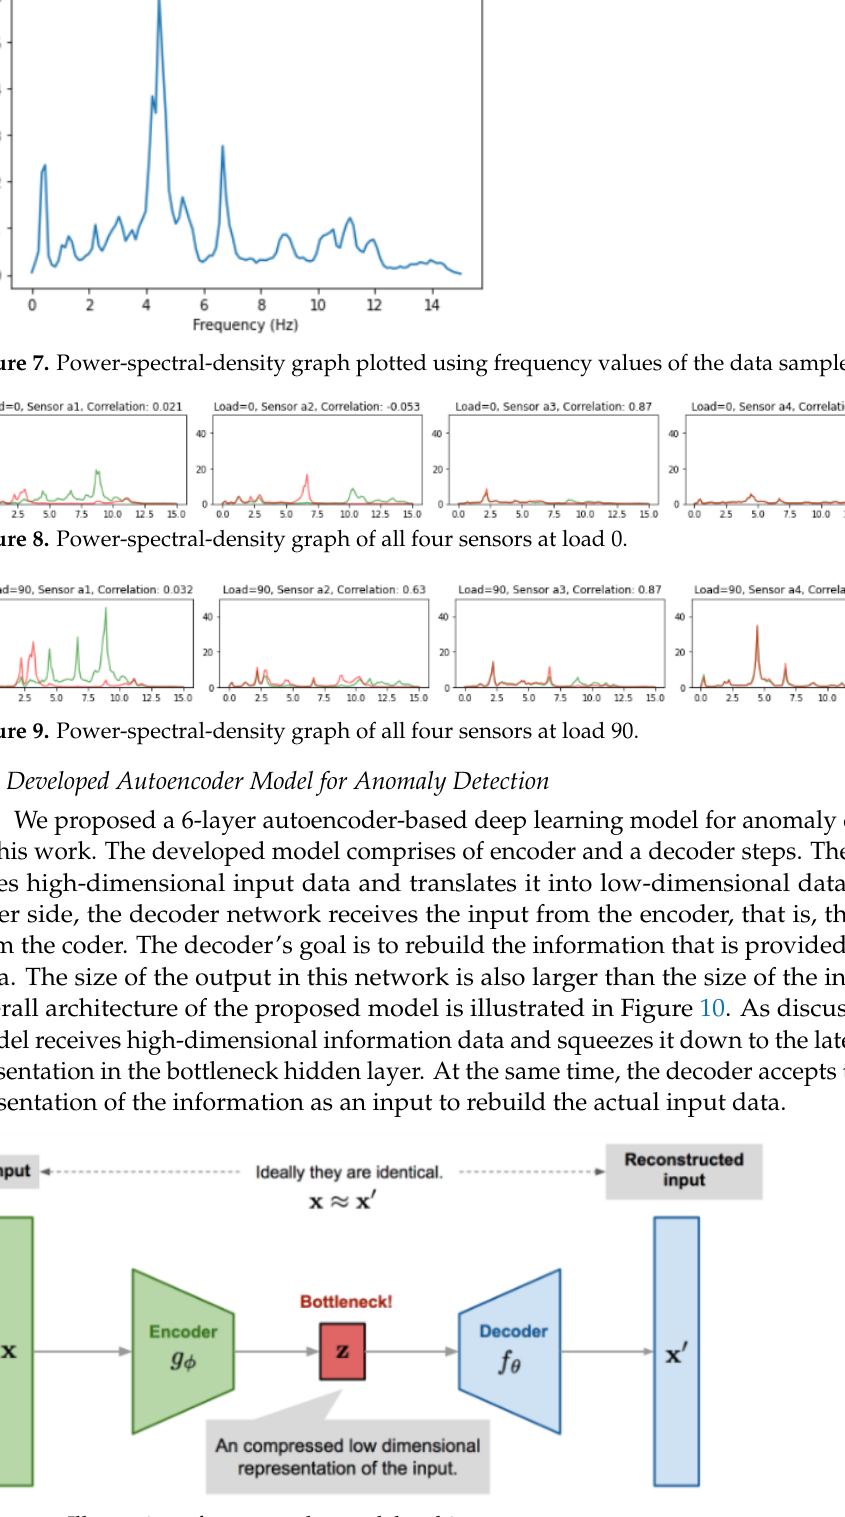
Figure 10. Illustration of autoencoder model